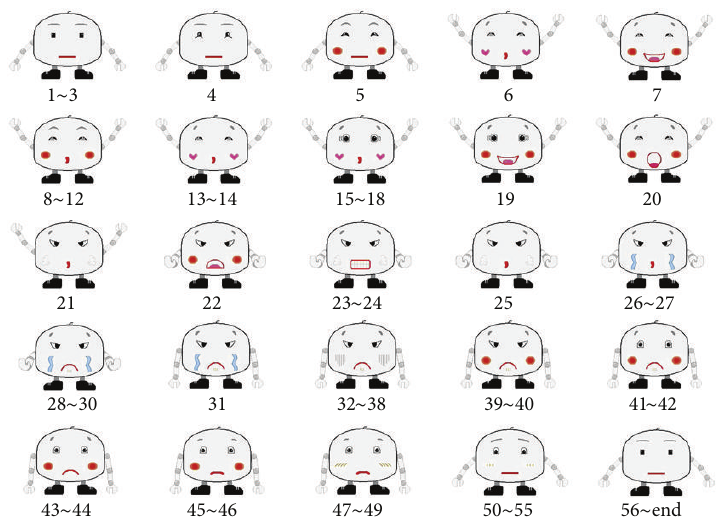
Figure 8: The emotional expressions based on emotions generated by senior